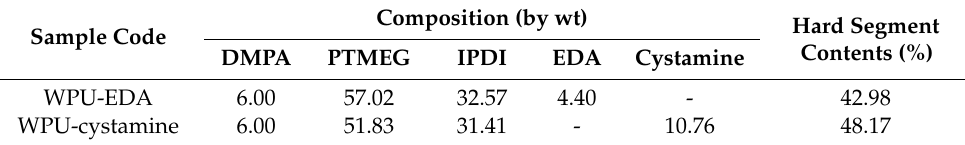
Table 3. Composition and sample code of prepared WPU.